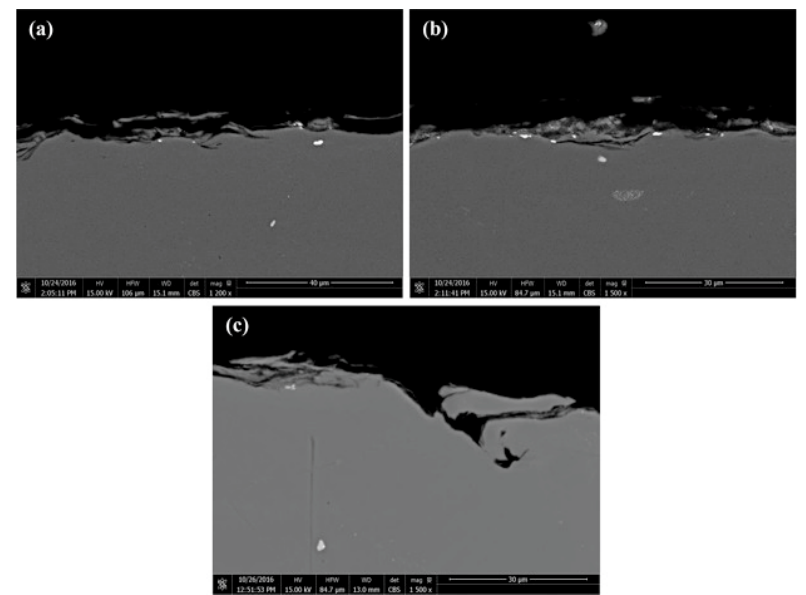
Figure 9. Scanning electron micrographs of the cross section of the RRA B206 aluminum alloy after 48 h of immersion in artificial seawater showing exfoliation corrosion for a scale bar of 40 µm ( a ) and 30 µm ( b , c ). Reprinted with permission of [21].